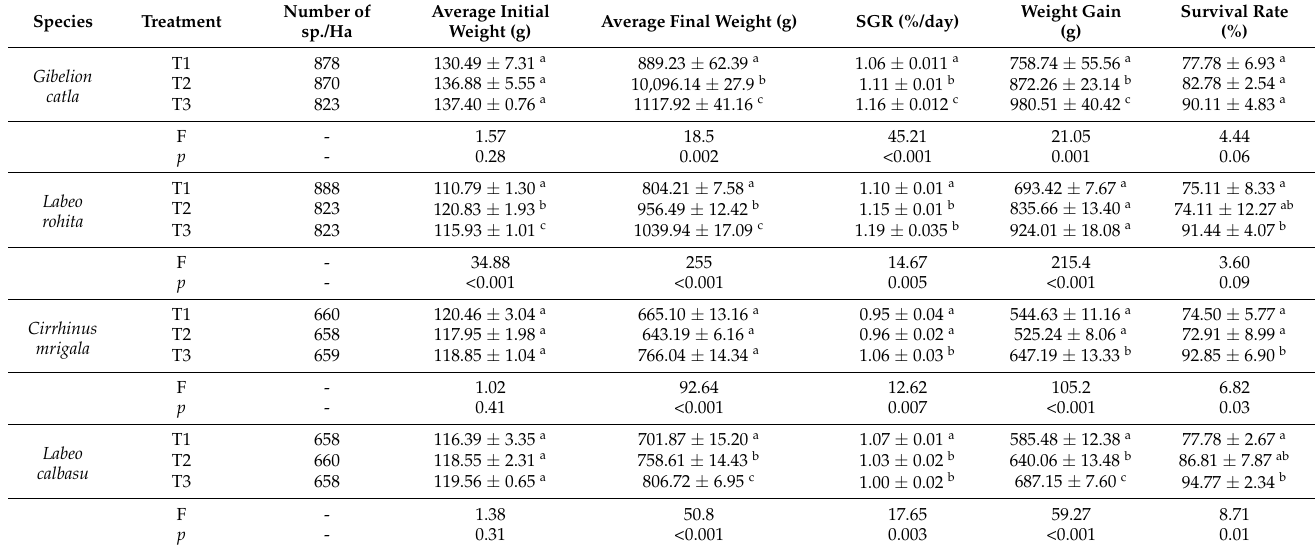
Table 2. Growth and production of fish under three different